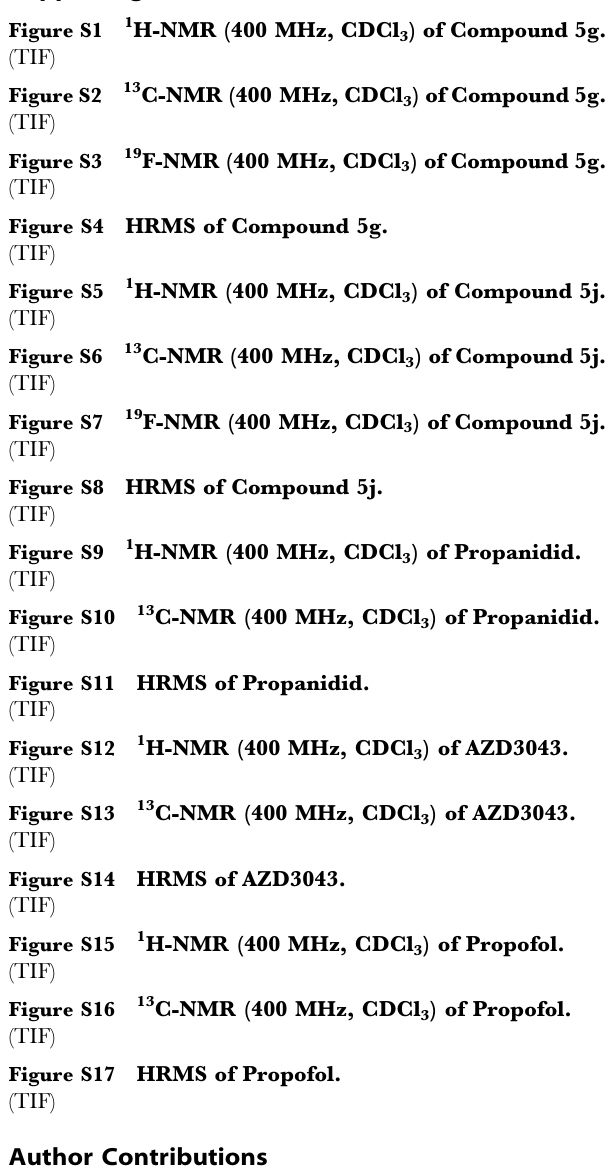
Figure S1 1 H-NMR (400 MHz, CDCl 3 ) of Compound 5g. (TIF) Figure S2 13 C-NMR (400 MHz, CDCl 3 ) of Compound 5g. (TIF) Figure S3 19 F-NMR (400 MHz, CDCl 3 ) of Compound 5g. (TIF) Figure S4 HRMS of Compound 5g. (TIF) Figure S5 1 H-NMR (400 MHz, CDCl 3 ) of Compound 5j. (TIF) Figure S6 13 C-NMR (400 MHz, CDCl 3 ) of Compound 5j. (TIF) Figure S7 19 F-NMR (400 MHz, CDCl 3 ) of Compound 5j. (TIF) Figure S8 HRMS of Compound 5j. (TIF) Figure S9 1 H-NMR (400 MHz, CDCl 3 ) of Propanidid. (TIF) Figure S10 13 C-NMR (400 MHz, CDCl 3 ) of Propanidid. (TIF) Figure S11 HRMS of Propanidid. (TIF) Figure S12 1 H-NMR (400 MHz, CDCl 3 ) of AZD3043. (TIF) Figure S13 13 C-NMR (400 MHz, CDCl 3 ) of AZD3043. (TIF) Figure S14 HRMS of AZD3043. (TIF) Figure S15 1 H-NMR (400 MHz, CDCl 3 ) of Propofol. (TIF) Figure S16 13 C-NMR (400 MHz, CDCl 3 ) of Propofol. (TIF) Figure S17 HRMS of Propofol.